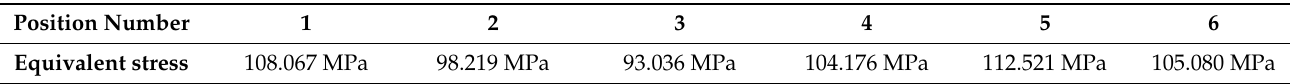
Figure 8. Large displacement positions of the COF machine. Table 1. Equivalent stresses of Positions 1–6.